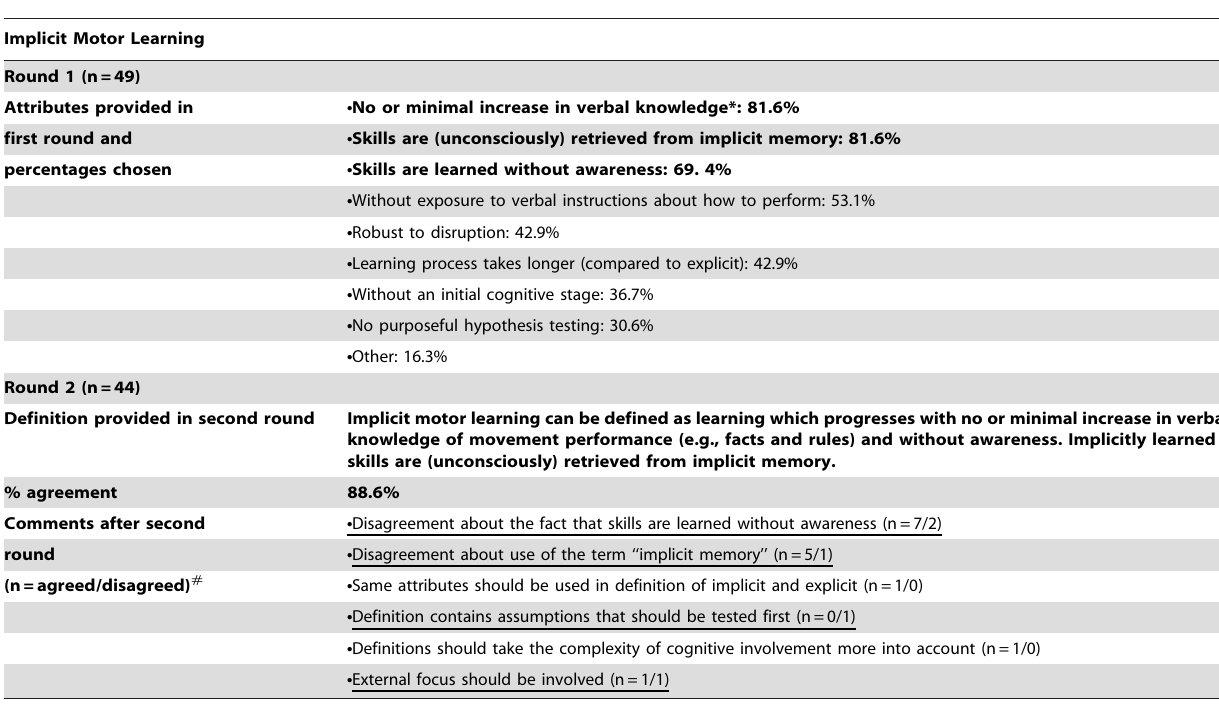
Implicit Motor Learning